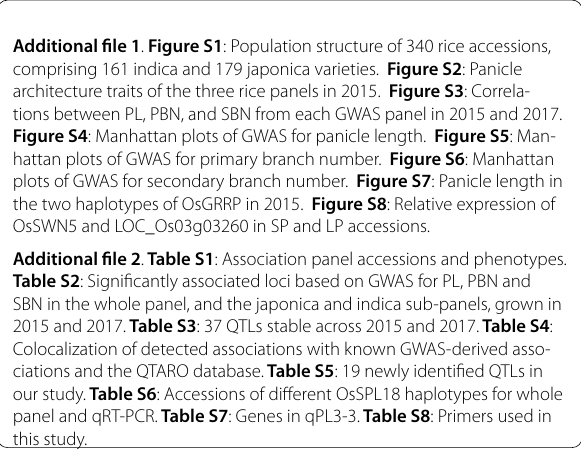
plots of GWAS for secondary branch number. Figure S7 : Panicle length in the two haplotypes of OsGRRP in 2015. Figure S8 : Relative expression of OsSWN5 and LOC_Os03g03260 in SP and LP accessions. Additional file 2 . Table S1 : Association panel accessions and phenotypes. Table S2 : Significantly associated loci based on GWAS for PL, PBN and SBN in the whole panel, and the japonica and indica sub-panels, grown in 2015 and 2017. Table S3 : 37 QTLs stable across 2015 and 2017. Table S4 : Colocalization of detected associations with known GWAS-derived asso- ciations and the QTARO database. Table S5 : 19 newly identified QTLs in our study. Table S6 : Accessions of different OsSPL18 haplotypes for whole panel and qRT-PCR. Table S7 : Genes in qPL3-3. Table S8 : Primers used in this